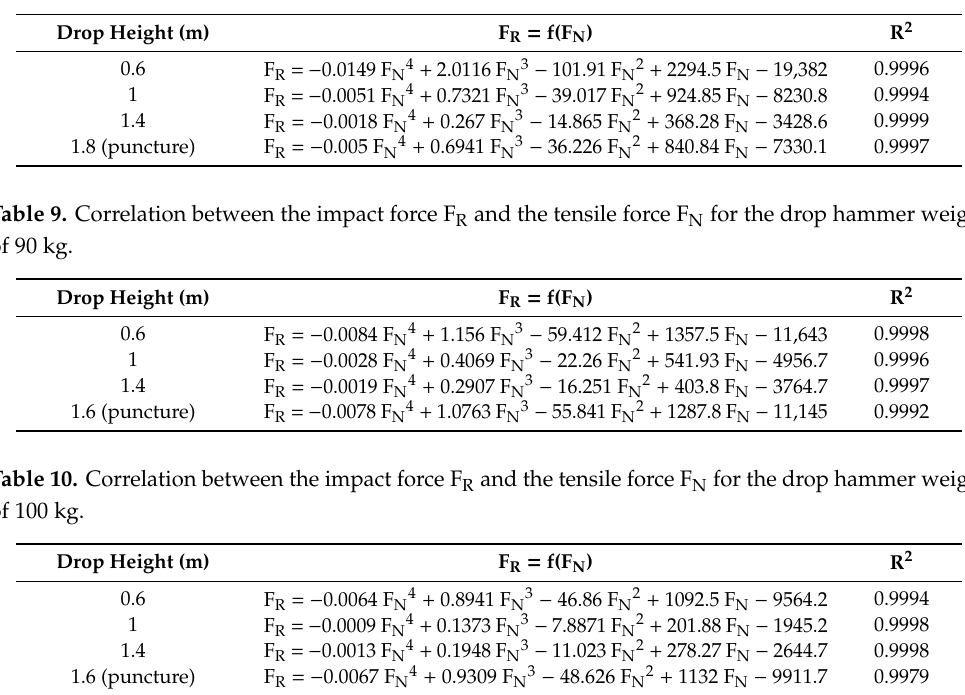
Table 8. Correlation between the impact force F R and the tensile force F N for the drop hammer weight of 80 kg.